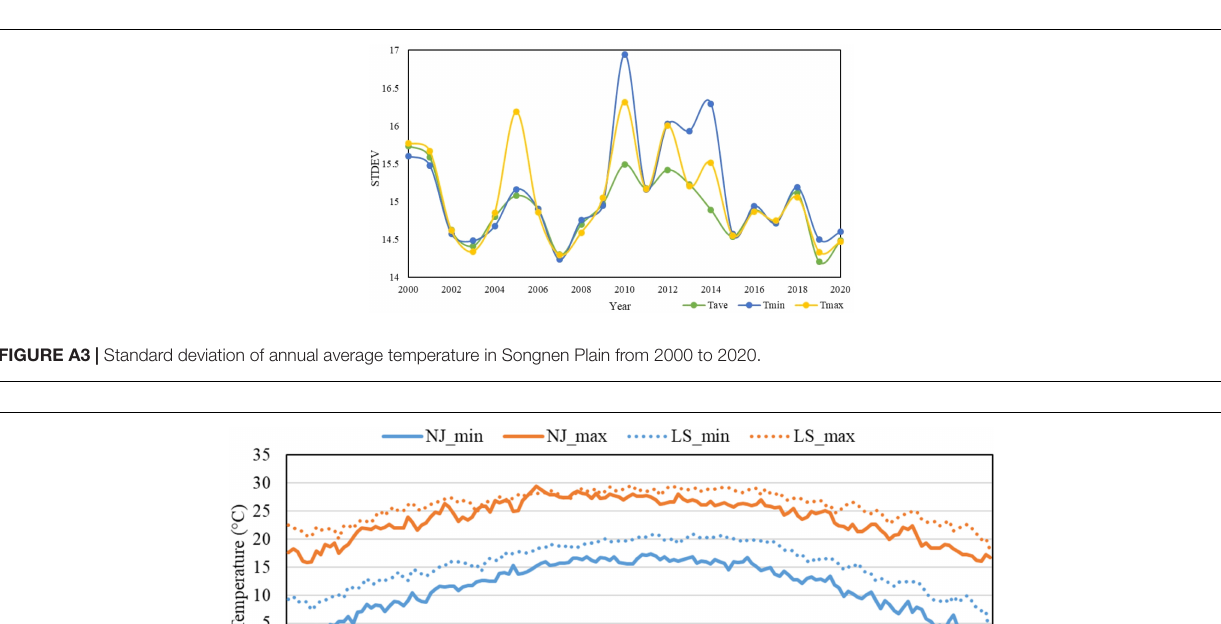
FIGURE A2 | The average daily temperature in the Songnen Plain from 2000 to 2020 is close to the average long-term situation. The gentle temperature change provides a better planting environment and is conducive for crops to adapt to environmental changes.